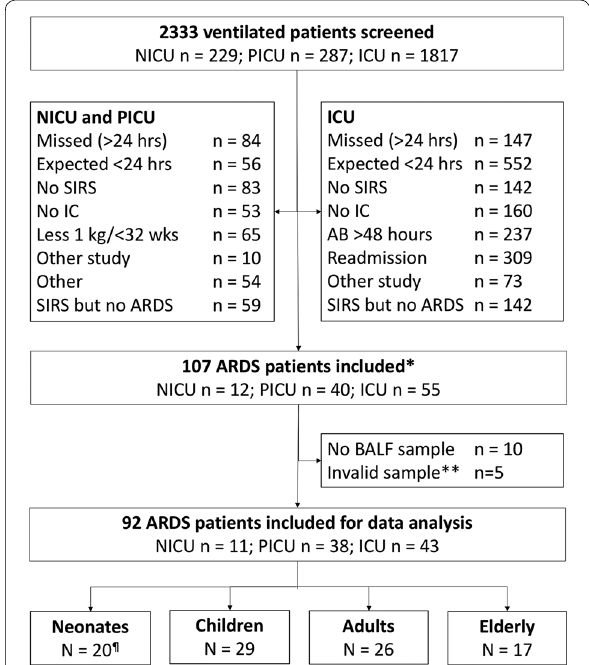
Fig. 1 Flowchart. * ARDS was defined by the Berlin definition; ** A sample was considered invalid if no proteins could be measured. ARDS acute respiratory distress syndrome ¶ 1 premature neonate, = 36 weeks at time of inclusion. The exclusion criteria were not exclusive. In case a patient fulfilled more than one exclusion criteria, only one was chosen to report. AB antibiotics, ARDS acute respiratory distress syndrome, BALF bronchoalveolar lavage fluid, No IC no informed consent, SIRS systemic inflammatory response